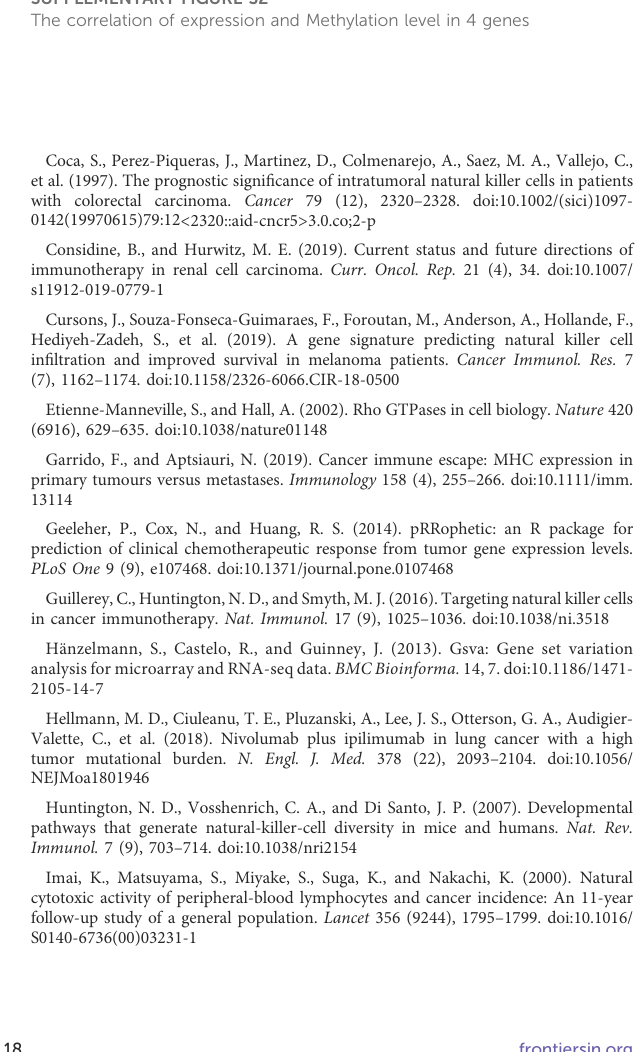
SUPPLEMENTARY FIGURE S1 Working fl ow chart SUPPLEMENTARY FIGURE S2 The correlation of expression and Methylation level in 4